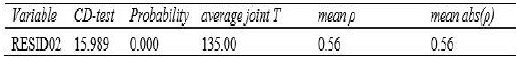
Table 3: Pesaran CD Test for Baseline Regression Model for